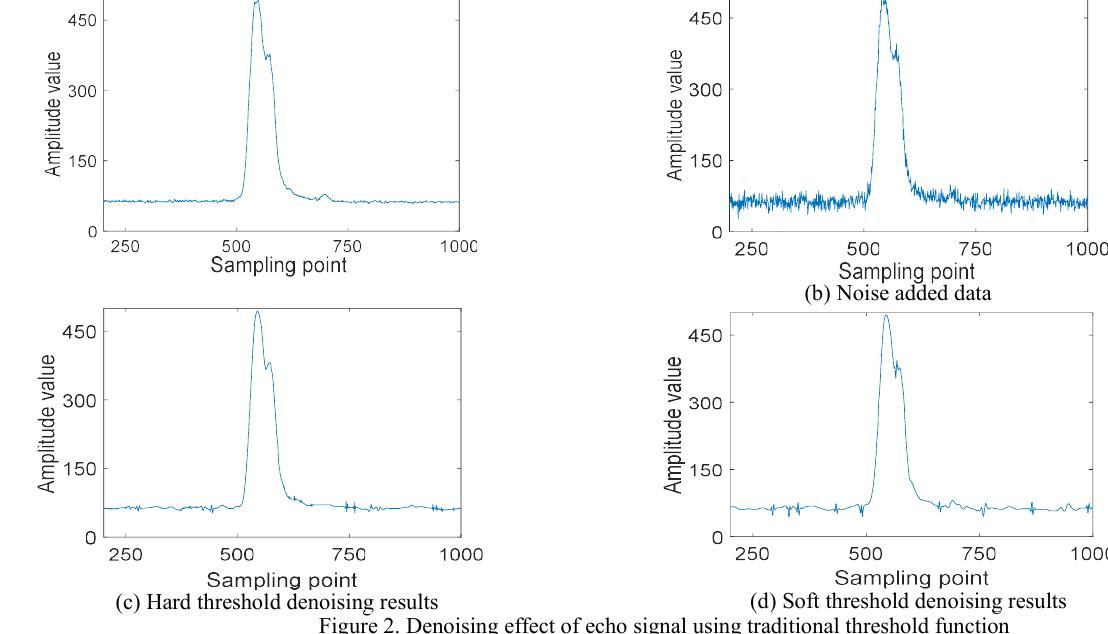
Figure 2. Denoising effect of echo signal using traditional threshold function